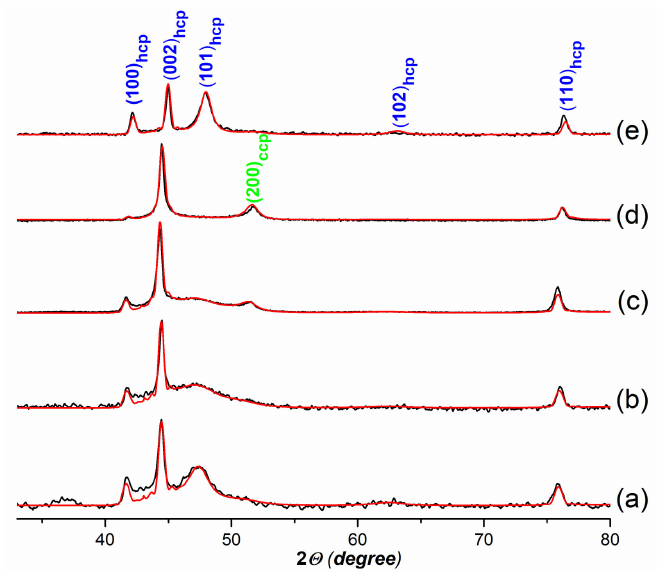
Figure 8. Experimental XRD patterns (black curves) and calculated XRD profiles (red curves) of the samples: Co_W8 ( a ); Co2Ni1_W8 ( b ); Co2Ni1_W0 ( c ); Co1Ni1_W8 ( d ); Co_AC ( e